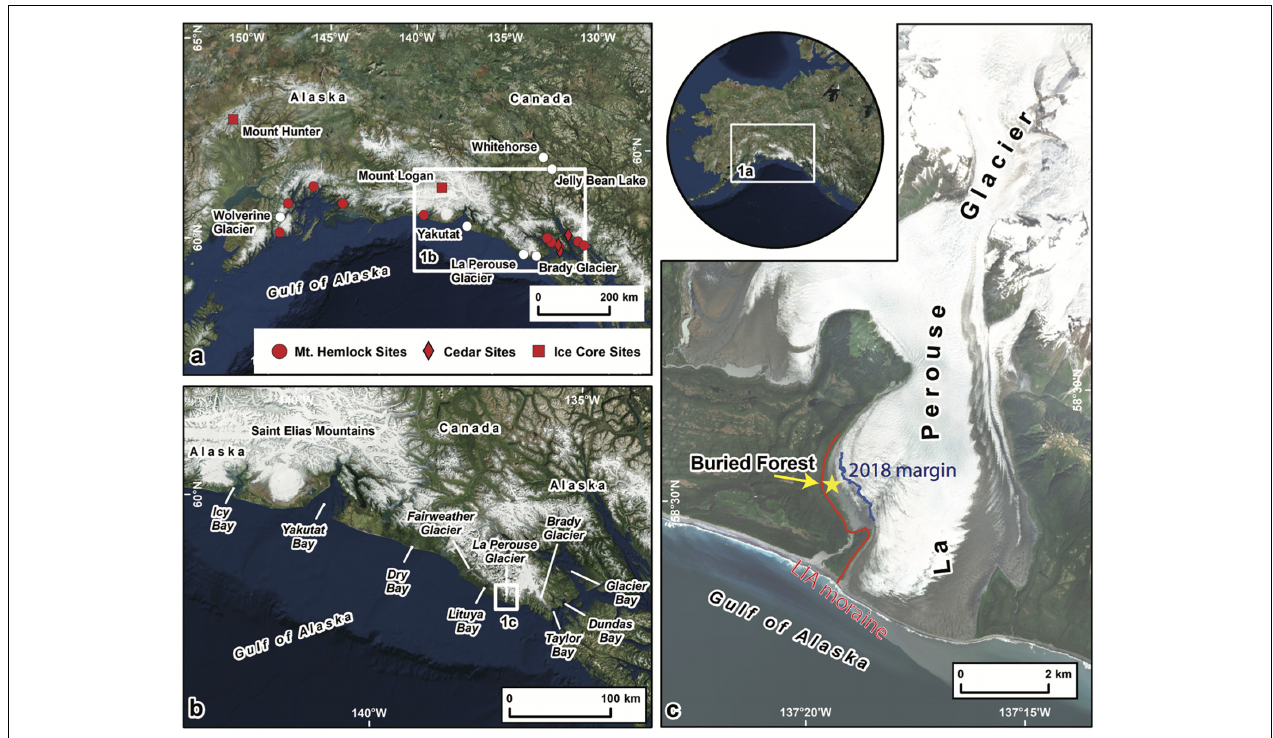
FIGURE 1 | Maps and aerial images of the study area. (a) Locations described in the text including sources of paleoclimate and tree-ring data. (b) Locations of glaciers described in the text. (c) Extent of La Perouse Glacier in 2010 (satellite imagery) with the location of the exhumed forest we crossdated ( Figure 2 ), the Little Ice Age moraine, and field-surveyed ice margin in July of